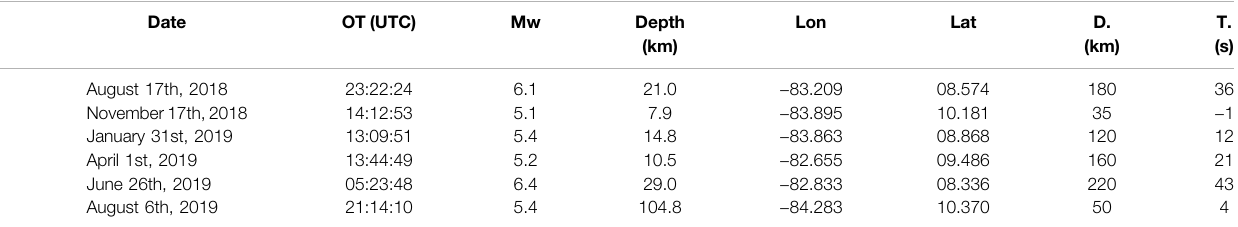
TABLE 1 | Seismic source parameters reported by the RSN for the six earthquakes used in this study. N (cid:1) number, OT (cid:1) origin time, Mw (cid:1) moment magnitude, Lon (cid:1) longitude, Lat (cid:1) latitude, D. (km) (cid:1) epicentral distance to San Jose, and T. (s) (cid:1) time for S-wave to arrive at San